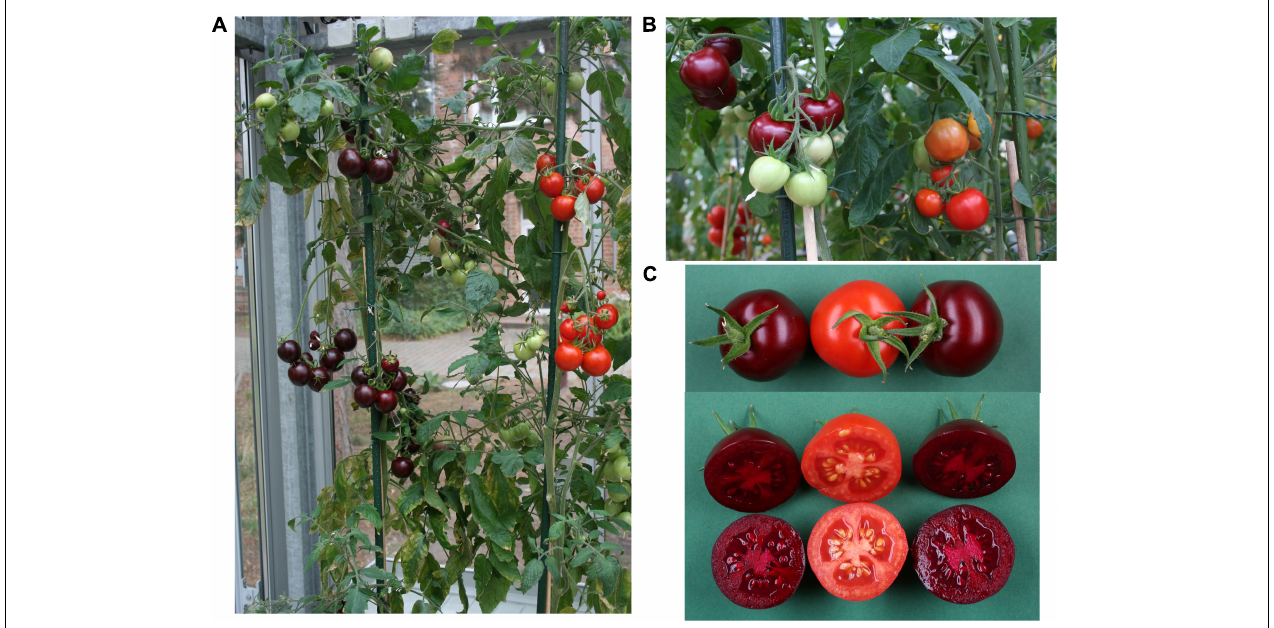
FIGURE 7 | Pictures of tomatoes from the backcross of M82 × pAGM51753 pt2. Sibling plants from the same cross, with or without the T-DNA are shown, with betalains (purple fruit) and without (orange fruits). Plants with fruits at different stages of ripening are shown, with inflorescences with all fruits ripe (A) or not all fruits ripe (B) , showing that betalains are produced only at the fruit ripening stage. (C) Fruits from siblings with or without betalain